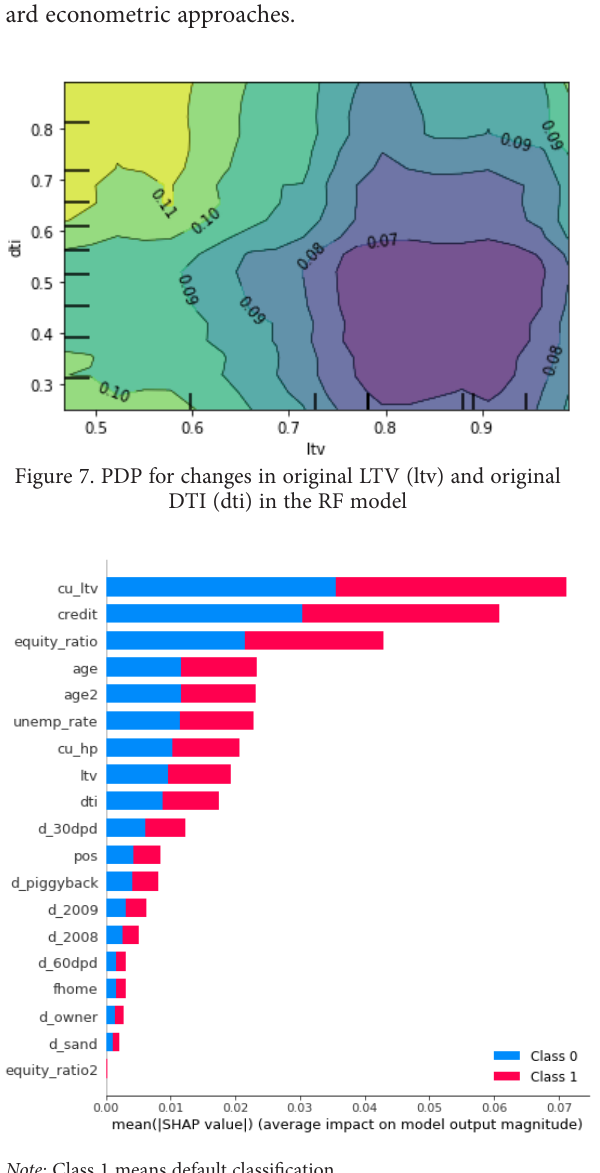
Note: Class 1 means default classification. Figure 8. Results of the SHAP value in the RF